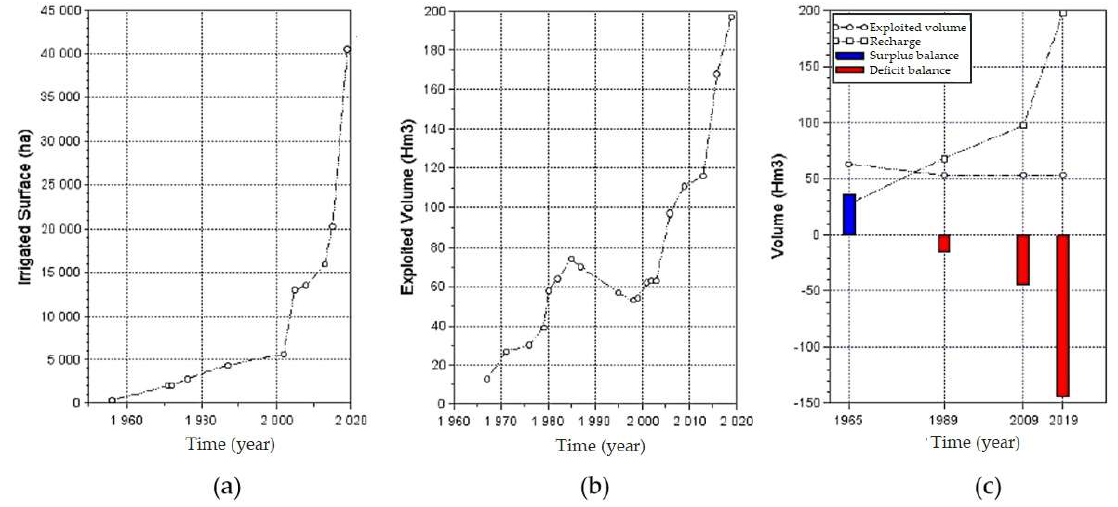
Figure 5. ( a ) Irrigated area (Ha). ( b ) Exploited volume (Hm 3 ). ( c ) Water balance [21].